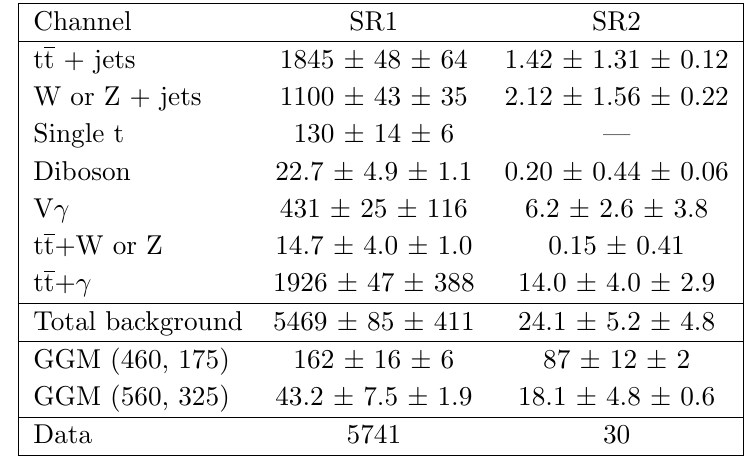
Table 4 . Observed data and expected background yields for the combined (e and (cid:22) ) signal regions. Expectations from two GGM signal model points are included, for which (460, 175) refers to m 460 GeV and m = 175 GeV, and similarly for (560, 325). The (cid:12)rst group of uncertainties is e (cid:31) 0 1 statistical and the second is